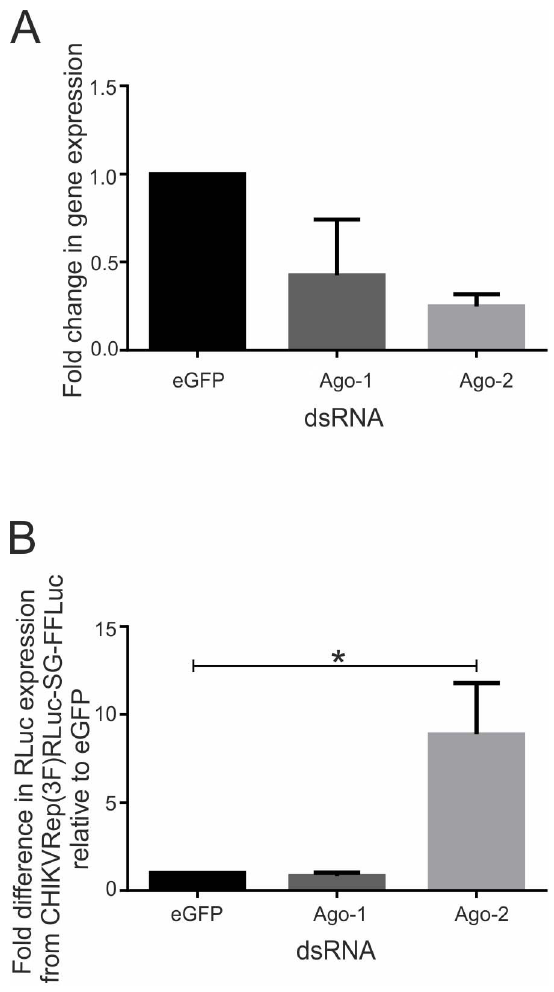
Figure 2. Knockdown of Ago-1 and Ago-2 in Aag2 cells and effect on CHIKV replication in Aag2 cells. ( A ) Ae. aegypti -derived Aag2 cells were transfected with 500 ng dsRNA and target transcripts analysed by qRT-PCR. Graph shows the relative transcript expression relative to eGFP-specific dsRNA treated cells and normalised to S7. Error bars show standard error of mean. ( B ) Aag2 cells were transfected with 500 ng of indicated dsRNAs, followed by transfection of in vitro transcribed CHIKVRep(3F)RLuc-SG-FFLuc replicon RNA and RLuc levels were measured. Graph shows mean RLuc levels from three independent experiments performed in triplicate. Error bars show the standard error of mean. *, Student’s t-test, p=0.045.